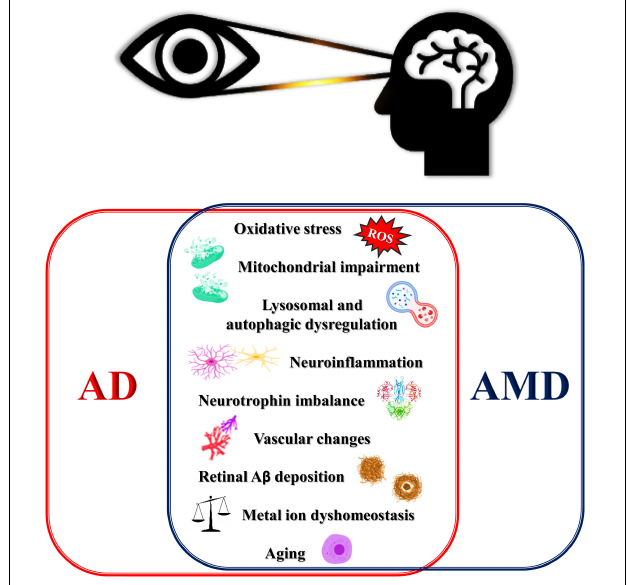
FIGURE 1 | Schematic for overlapping degenerative mechanisms shared by AMD and AD. These pathways have been associated with brain and retina degeneration, cognitive, deficits and loss of vision. AD, Alzheimer’s disease; AMD, age-related macular degeneration; ROS, reactive oxygen species.